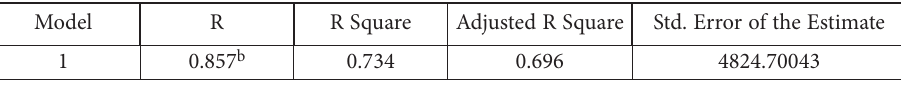
Table 5. Summary of the Regression Model